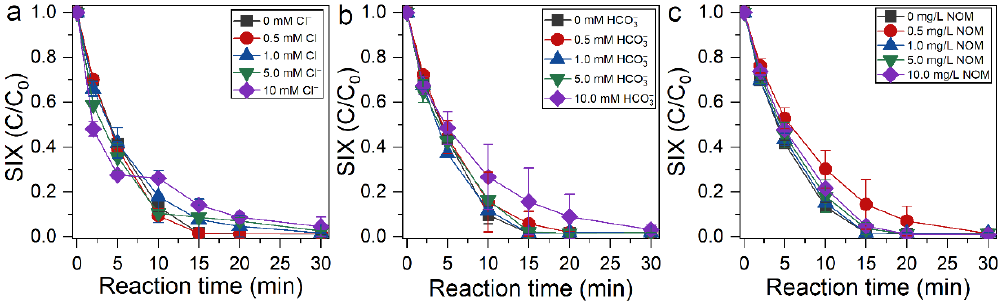
Figure 6. Effects of ( a ) Cl − , ( b ) HCO (cid:2871)(cid:2879) , and ( c ) NOM on the degradation of SIX by chalcopyrite–PMS oxidation.